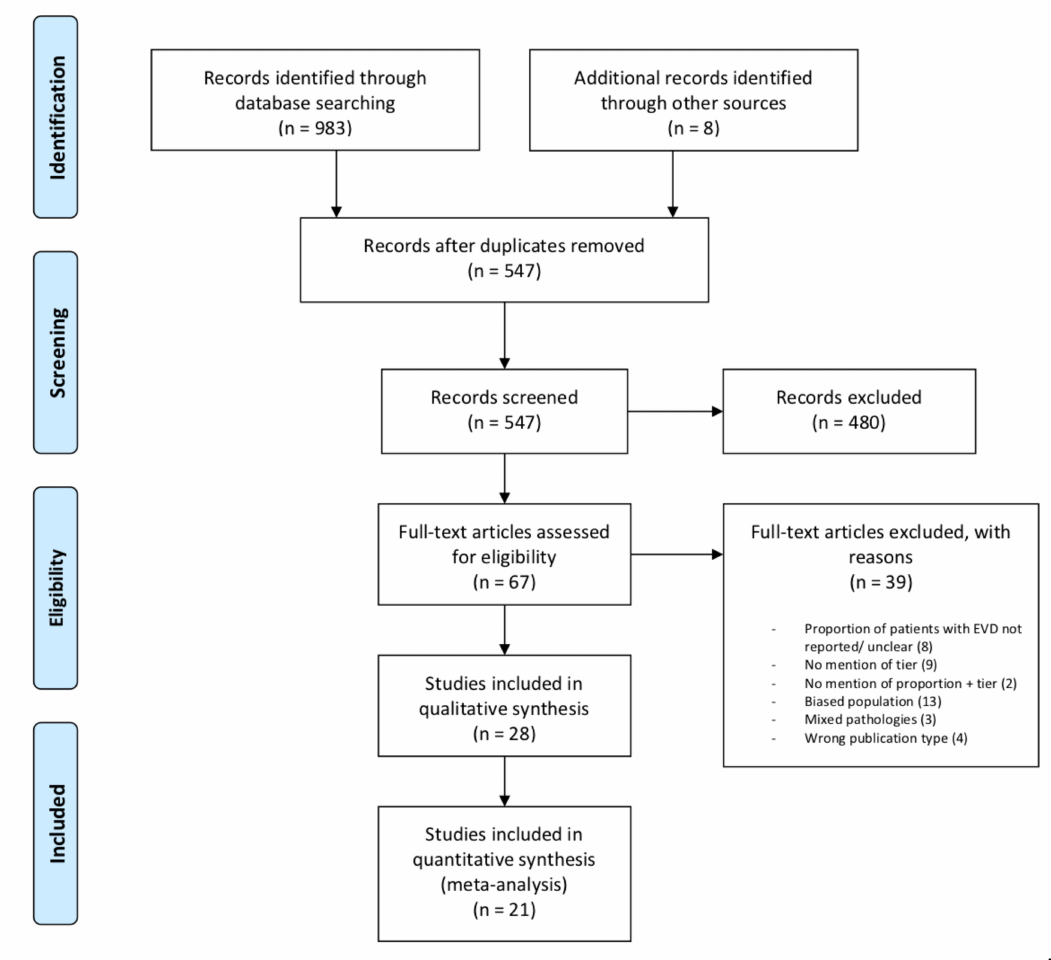
Figure 1. Preferred reporting items for systematic reviews and meta-analyses (PRISMA) flow diagram outlining the search strategy and reasons for the exclusion of full-text